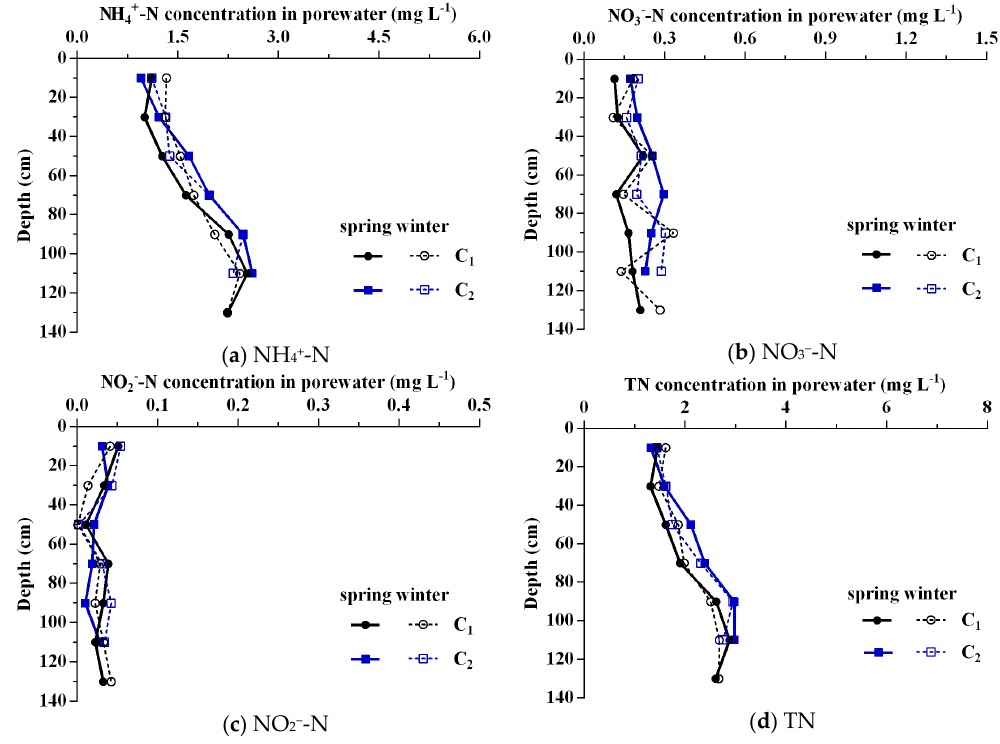
Figure 6. Vertical profiles of nitrogen in the porewater of the hyporheic zone at the center sites in Lake Taihu during spring and winter 2016.